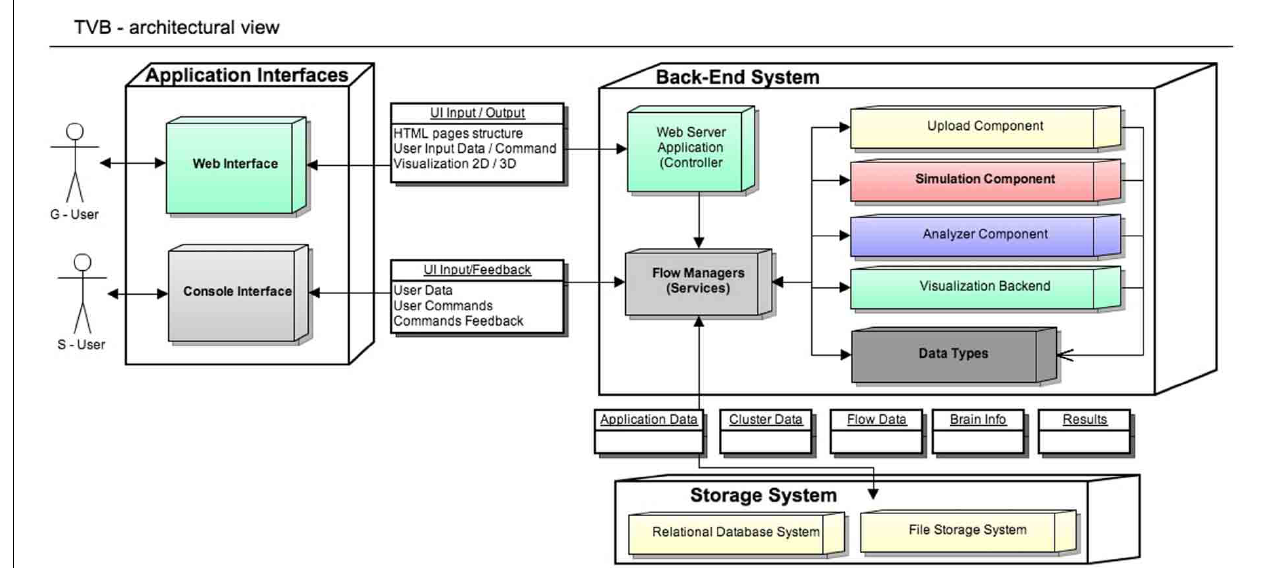
“active data” in the sense that, when TVB is configured with a database, data contained in TVB- Datatypes instances are automatically persistent. Currently the console interface works without the storage layer, keeping the results just in memory. S-Users need to manually handle data import and export